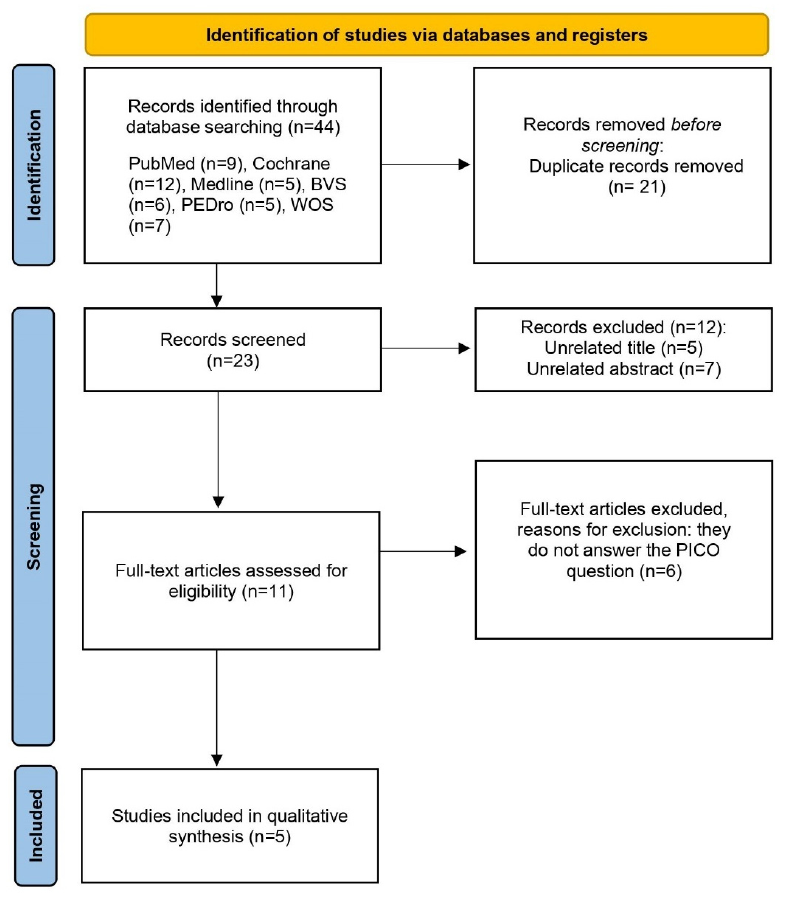
Figure 1. PRISMA flow diagram of the study selection process.